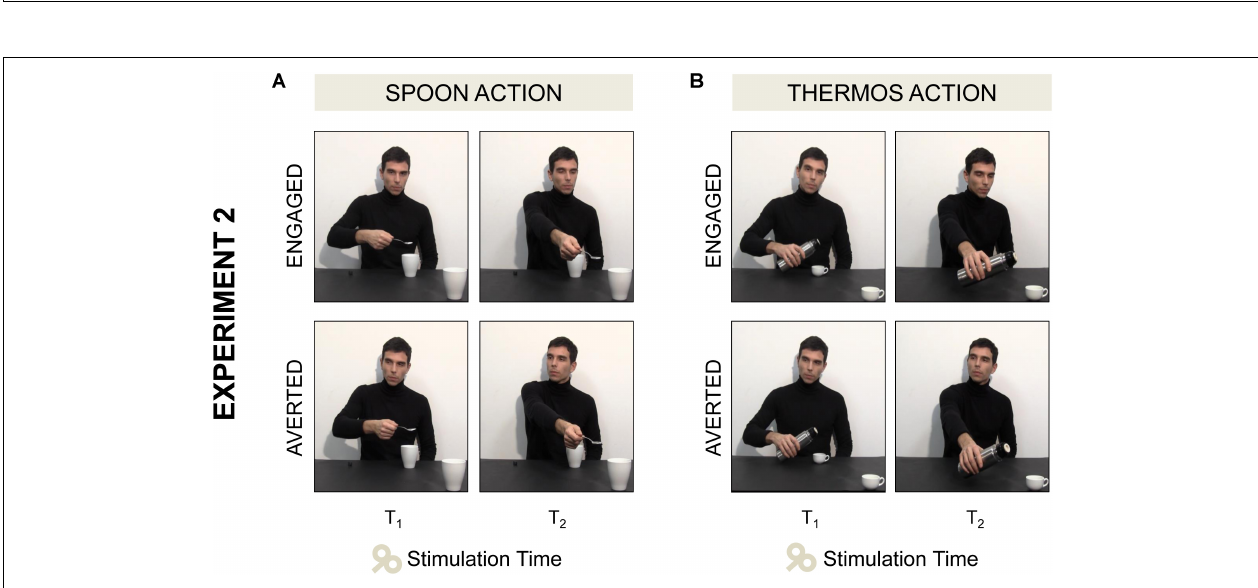
FIGURE 2 | MEP values and Questionnaire scorings for Experiment 1. A positive correlation between the reported tendency to grab the nearest mug at the end of the observed action (Q2) and ADM MEP values for the Direct Gaze condition is shown in panel (A) . ADM MEP values for the High and the Low Responders in the Direct Gaze condition are graphically represented in panel (B) . Asterisk indicates a statistically significant difference ( p < 0.05). Bars refer to the standard errors. Mean scorings for each item of the Questionnaire on the basis of the clusters (High and Low responders) are reported in panel (C) .